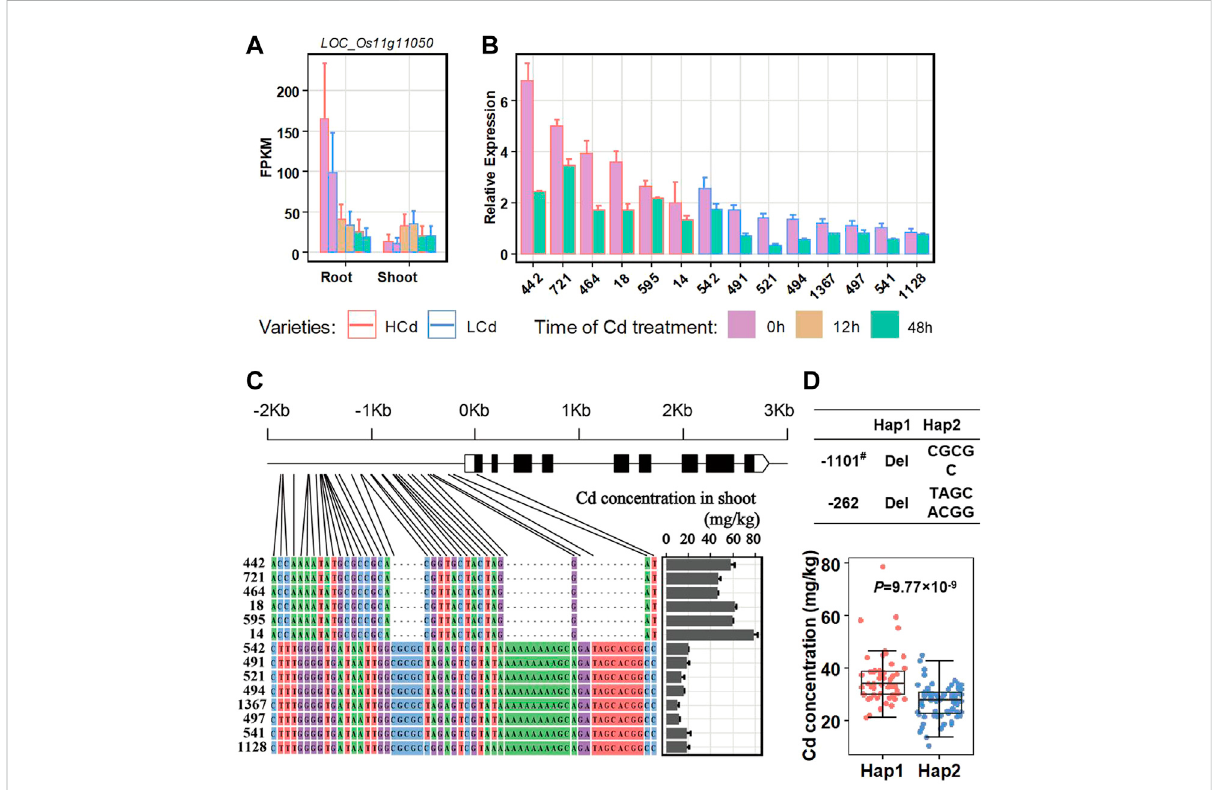
FIGURE 5 Expression changes of the candidate gene LOC_Os11g11050 in the root and shoot after Cd treatment between high and low Cd accumulation varieties. (A) Detecting LOC_Os11g11050 expression by transcriptomic analysis. (B) Detecting LOC_Os11g11050 expression in the root with qRT- PCR. (C) Sequence comparisons of the LOC_Os11g11050 promoter. HCd, high Cd accumulation varieties. LCd, low Cd accumulation varieties. (D) Boxplots for the Cd concentration based on haplotypes (Hap1 and Hap2; Hap1 had the deletions in the promoter, Hap2 did not have